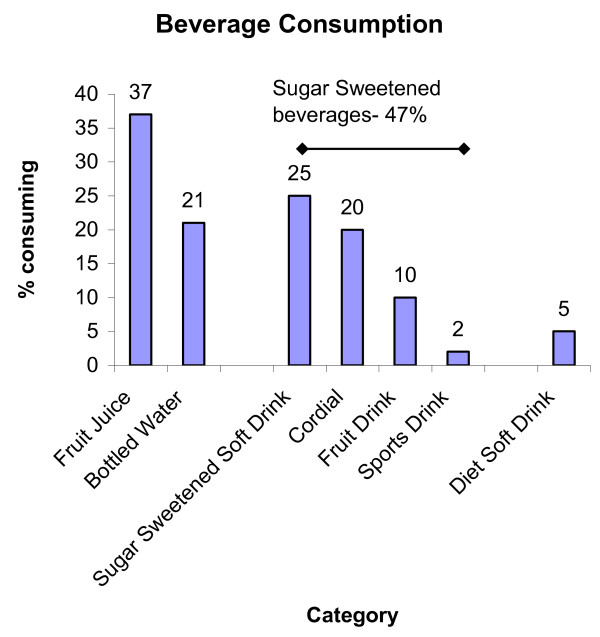
Categories of beverage consumed by children of all ages (n = 4487).